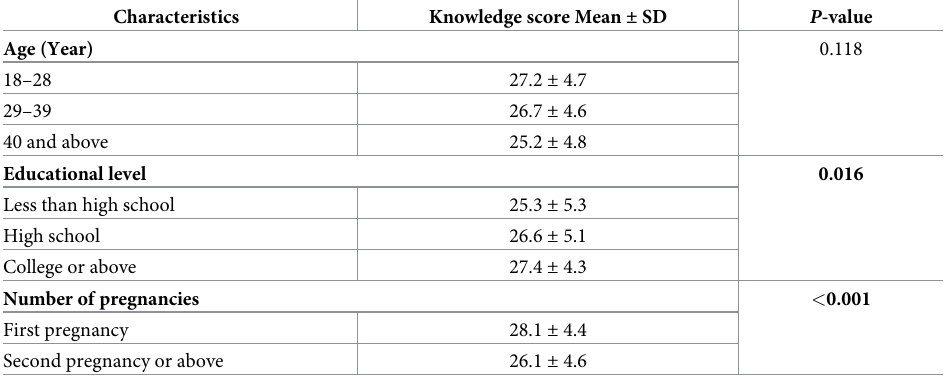
Table 9. Association between total food safety awareness score sociodemographic characteristics of participants (n = 354) 1